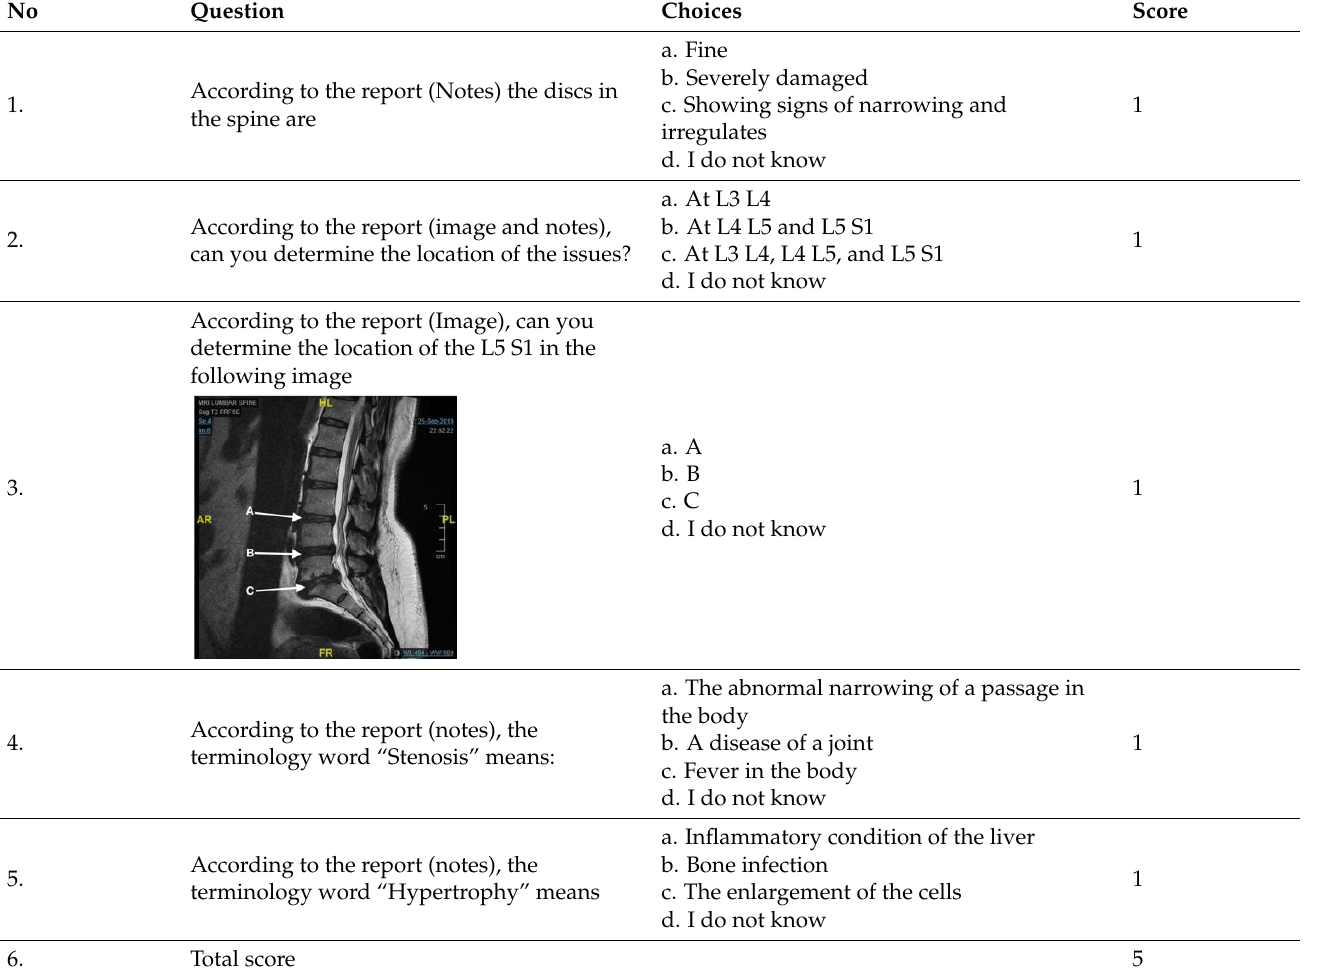
Table 3. RCQ questions to measure participant understanding.